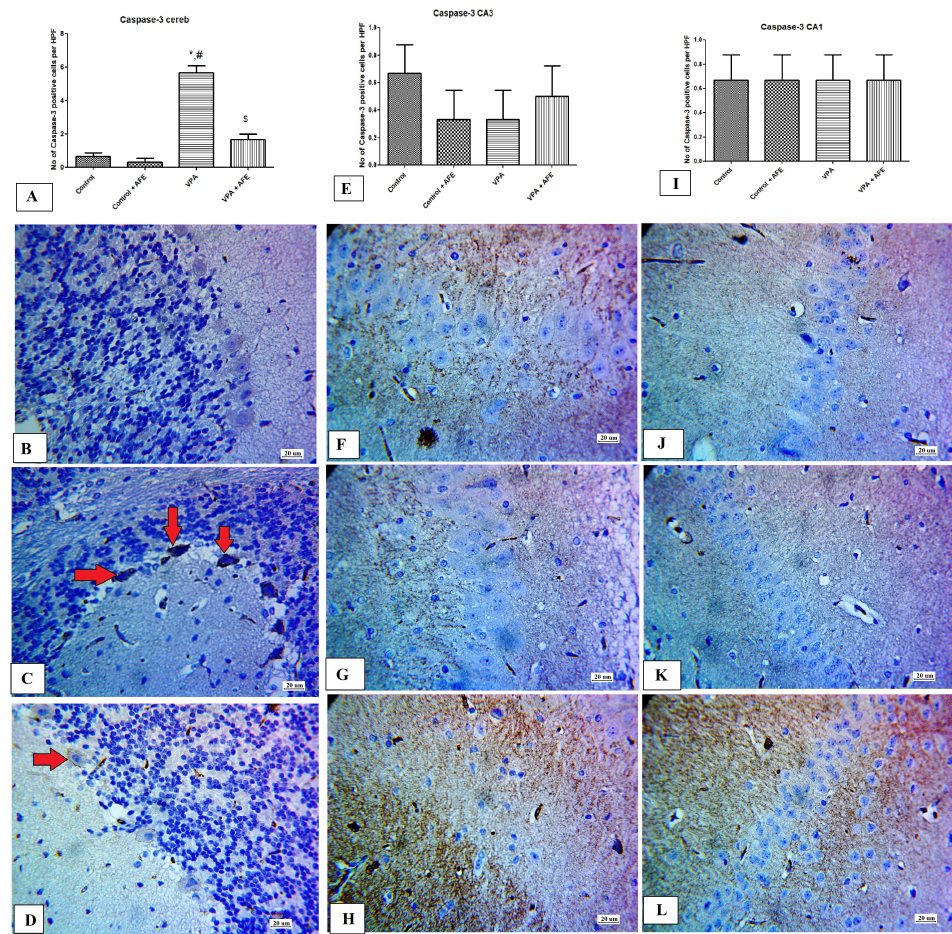
Figure 5. Effect of AFE on the caspase-3 expression in the cerebellum and hippocampus. ( A , E , I ) show the mean number of caspase-3 positive cells in the Purkinje cells (PC) layer of the cerebellar cortex, CA3 hippocampal region, and CA1 hippocampal region of different groups, respectively. ( B – D ) show cytoplasmic expression of caspase-3 (red arrows) in the PC of the cerebellar cortex of the control, VPA, and VPA + AFE groups, respectively. ( F – H ) show negative cytoplasmic expression of caspase-3 in CA3 of the control, VPA, and VPA + AFE groups, respectively. ( J – L ) show negative cytoplasmic expression of caspase-3 in CA1 of the control, VPA, and VPA + AFE groups, respectively (400 × ). * significant vs. control group, # significant vs. control + AFE group, and $ significant vs. VPA